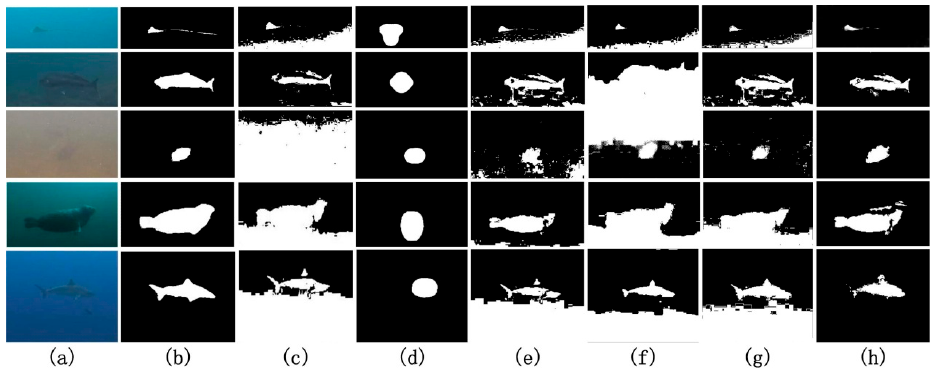
Figure 6. Underwater object detection. ( a ) Underwater image; ( b ) ground-truth; ( c ) Otsu; ( d ) saliency; ( e ) compatible color; ( f ) contour segmentation; ( g ) pulse-coupled neural network (PCNN); ( h ) our approach. Table 1. Average performance comparison of Otsu, saliency, compatible color, contour, PCNN, and our method. Precision (Pr); true positive rate (TPR); F-score (FS); similarity (Sim); false positive rate (FPR); percentage of wrong classifications (PWC).